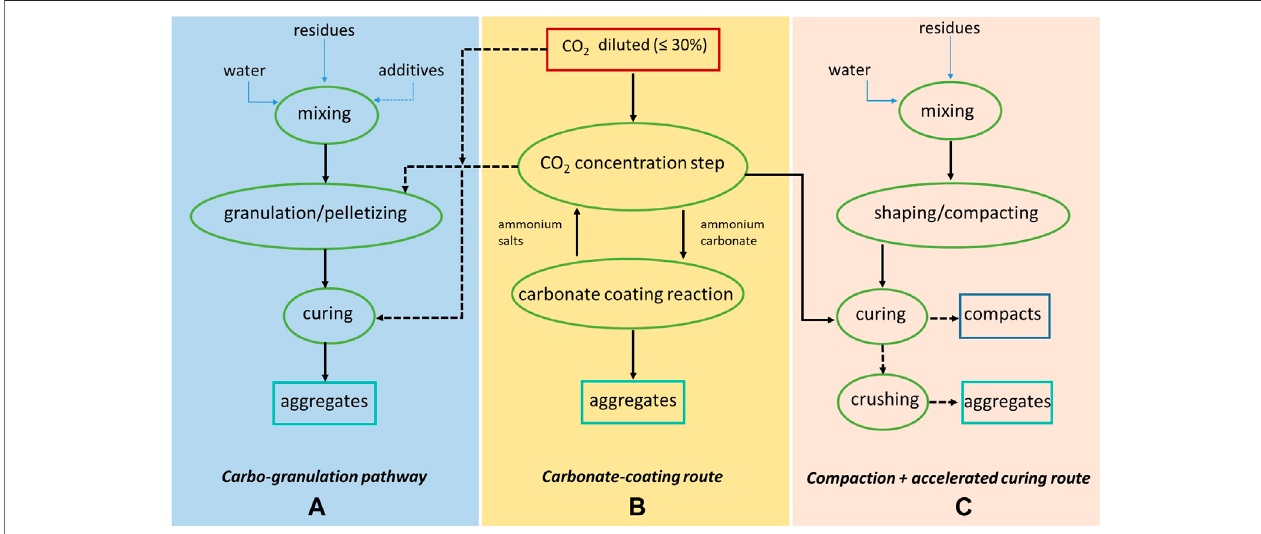
FIGURE 3 | Mineral carbonation pathways to produce aggregates or compacts. (A) Carbo-granulaion pathway. (B) Carbonate-coating route. (C) Compacting + accelerated curing route.